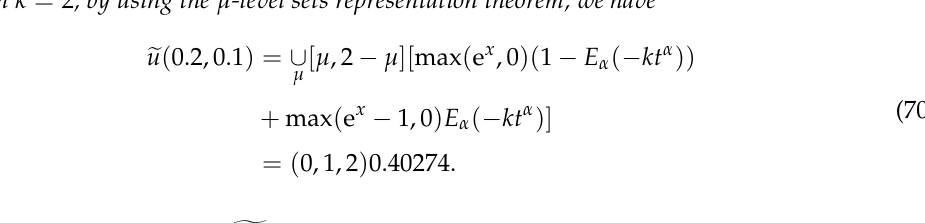
Table 3. H [ (cid:101) u ( x , t )] and max | (cid:103) Res ( x , t ) | by ETHPM, HPM, RPSM, CFADM for α = 1, k =